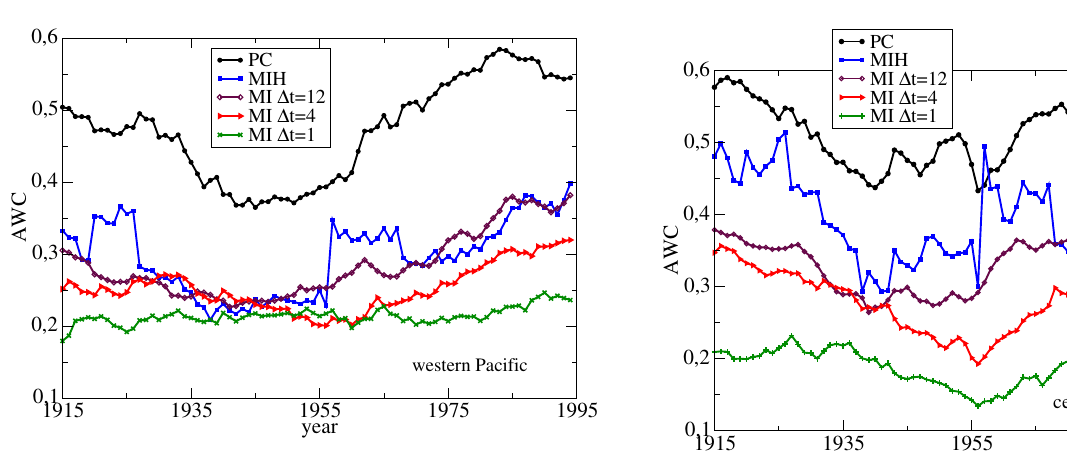
Figure 6. Temporal evolution of the AWC in the WP box. The net- works are built by evaluating 30-year windows of the 200mb eddy geopotential height field (NOAA) with every methodology used in this work. For each mean AWC value the time periods corresponding to 15 years before and 15 years after were considered.